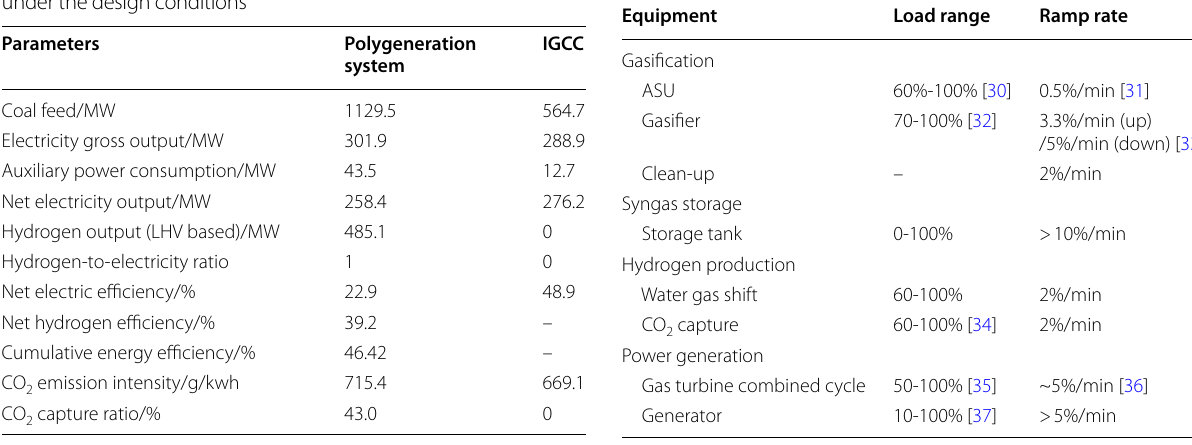
Table 6 Dynamic characteristics of the primary